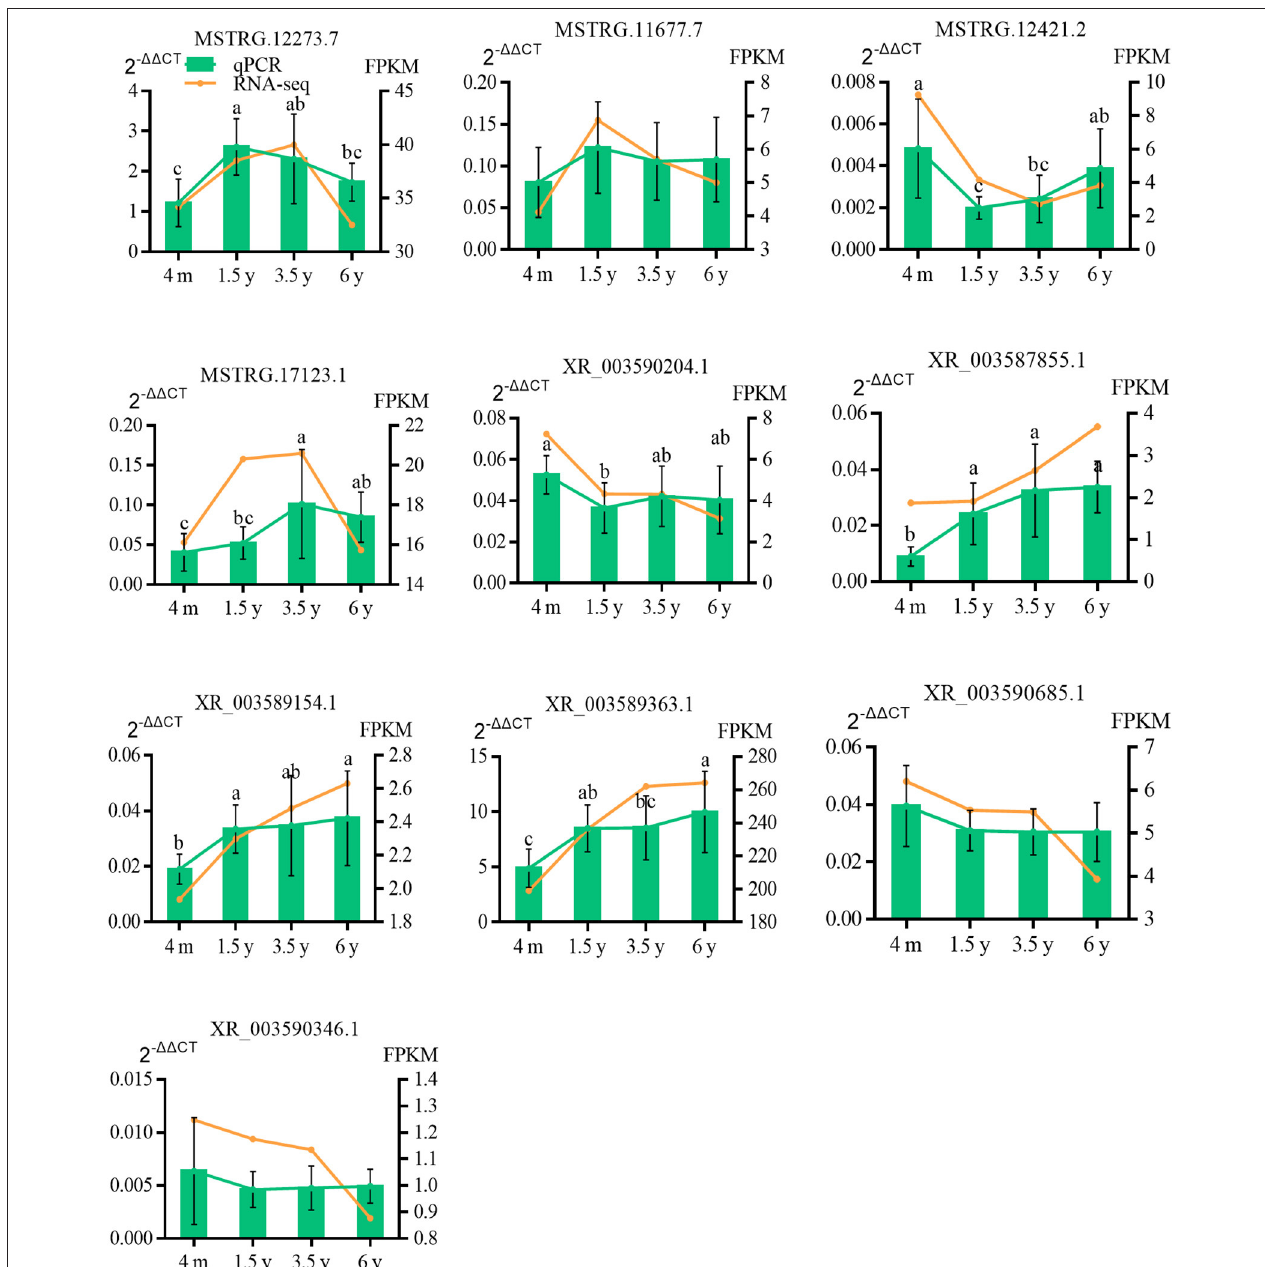
FIGURE 8 | Comparison of the expression levels of lncRNA between RNA-Seq and RT-qPCR. RT-qPCR data were shown as the means ± S.D. Different letters (a–c) indicate significant difference between different ages ( P < 0.05). 2 − 11 CT was the result of RT-qPCR, and FPKM was the result of